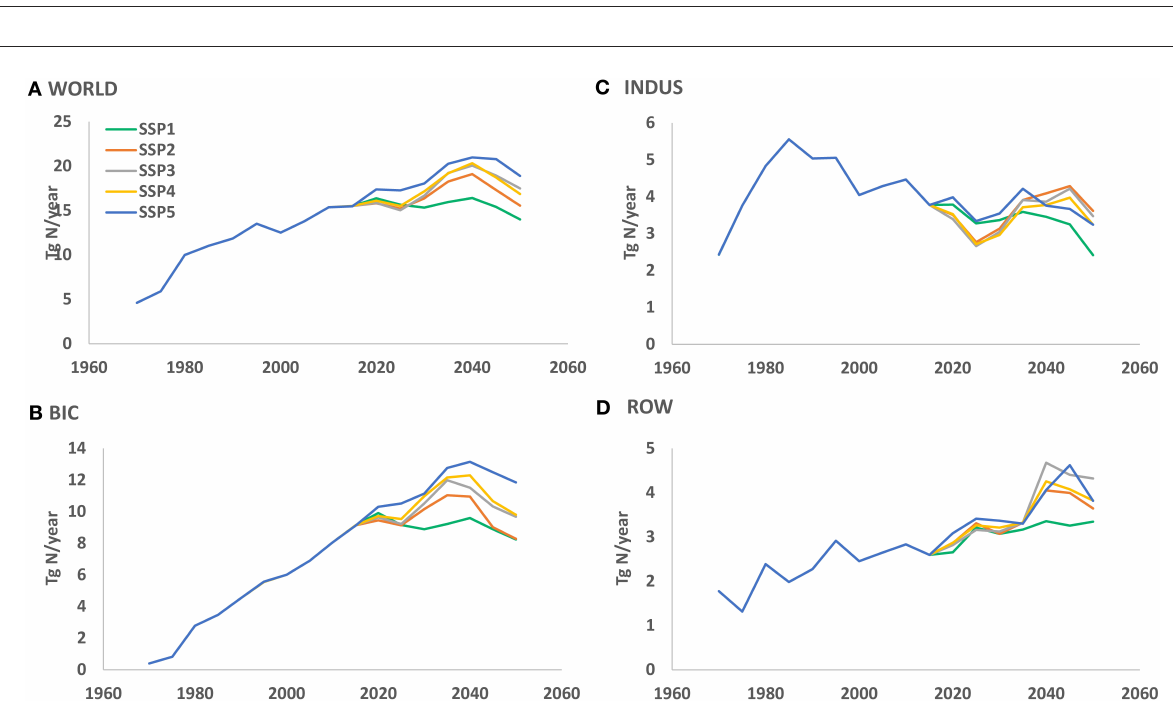
delivery per capita decreases which means that there is less N and P loss to the rivers per capita. However the population is